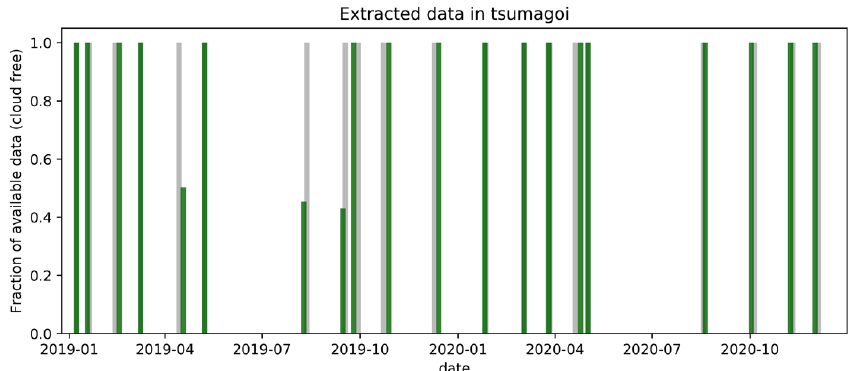
Figure 2. Sentinel-1 and Sentinel-2 data acquired in Tsumagoi.